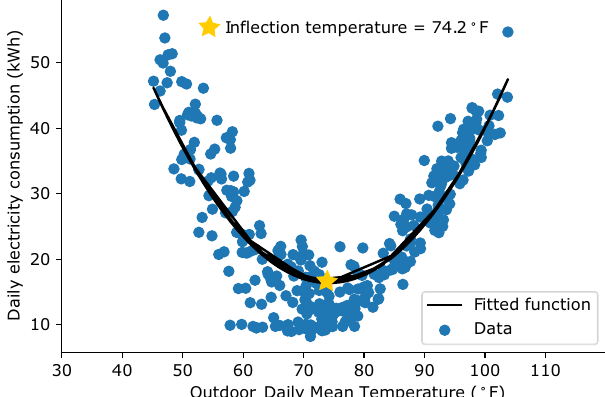
Fig. 2 Identifying the in fl ection temperature for daily electricity consumption and local daily mean outdoor temperature. This graph represents the daily electricity consumption of one household for one year ( N = 365). The star marks the in fl ection temperature for this household for this year. We note that our true temperature response function includes electricity price, weekend, holiday, day of the week, and month of the year effects. The in fl ection temperature is the minimum of the quadratic temperature response function between the residuals after controlling for these factors and outdoor